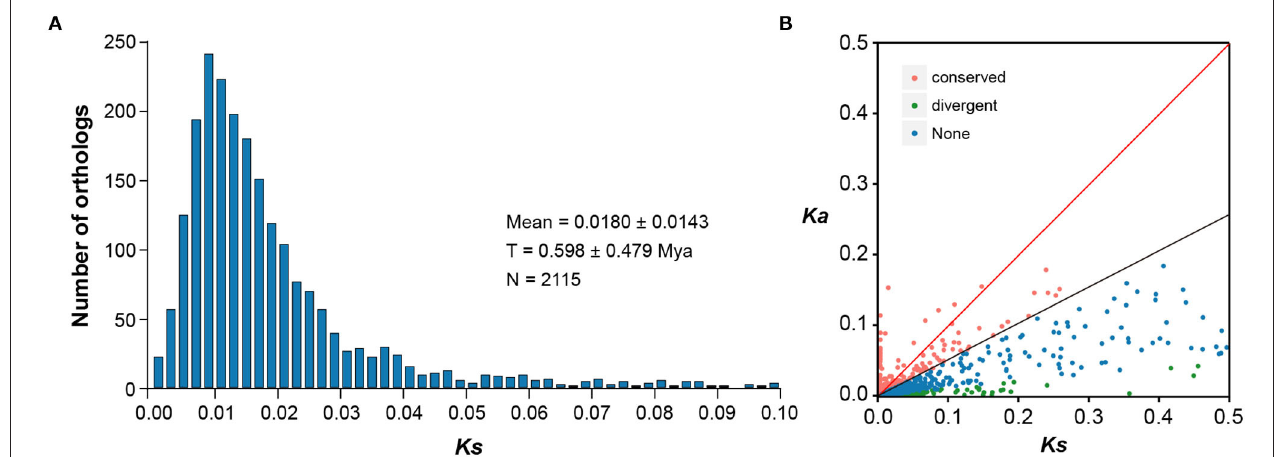
FIGURE 3 | Distribution of Ka and Ks for 6,830 pairs of the putative orthologous genes between E. fischeriana and E. ehracteolata . (A) The Ks distribution of orthologs between E. fischeriana and E. ehracteolata and their divergence is shown by the peak of Ks at 0.018 ± 0.014. (B) The orthologs with Ka / Ks > 1 fall above the red line whereas those with Ka/Ks = 0.5–1.0 fall between the black and red